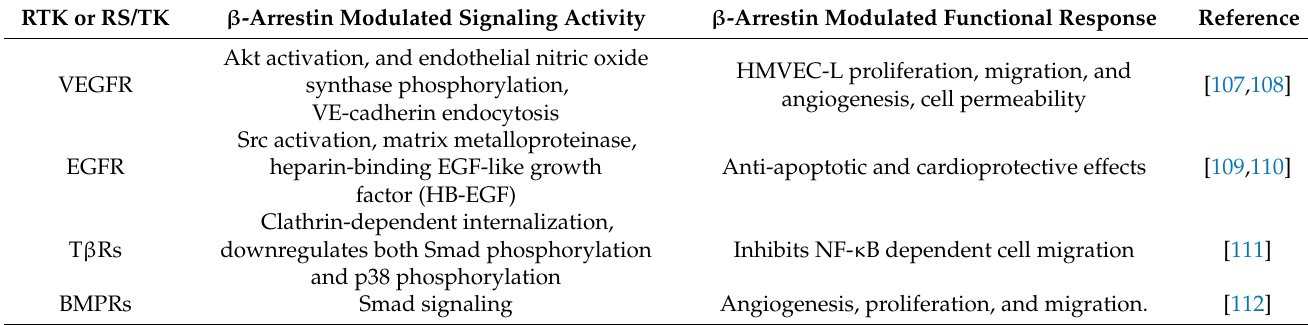
Table 2. Summary of β -arrestin-mediated signaling at selected RTKs and RS/TKs in endothelial cells. RTK or